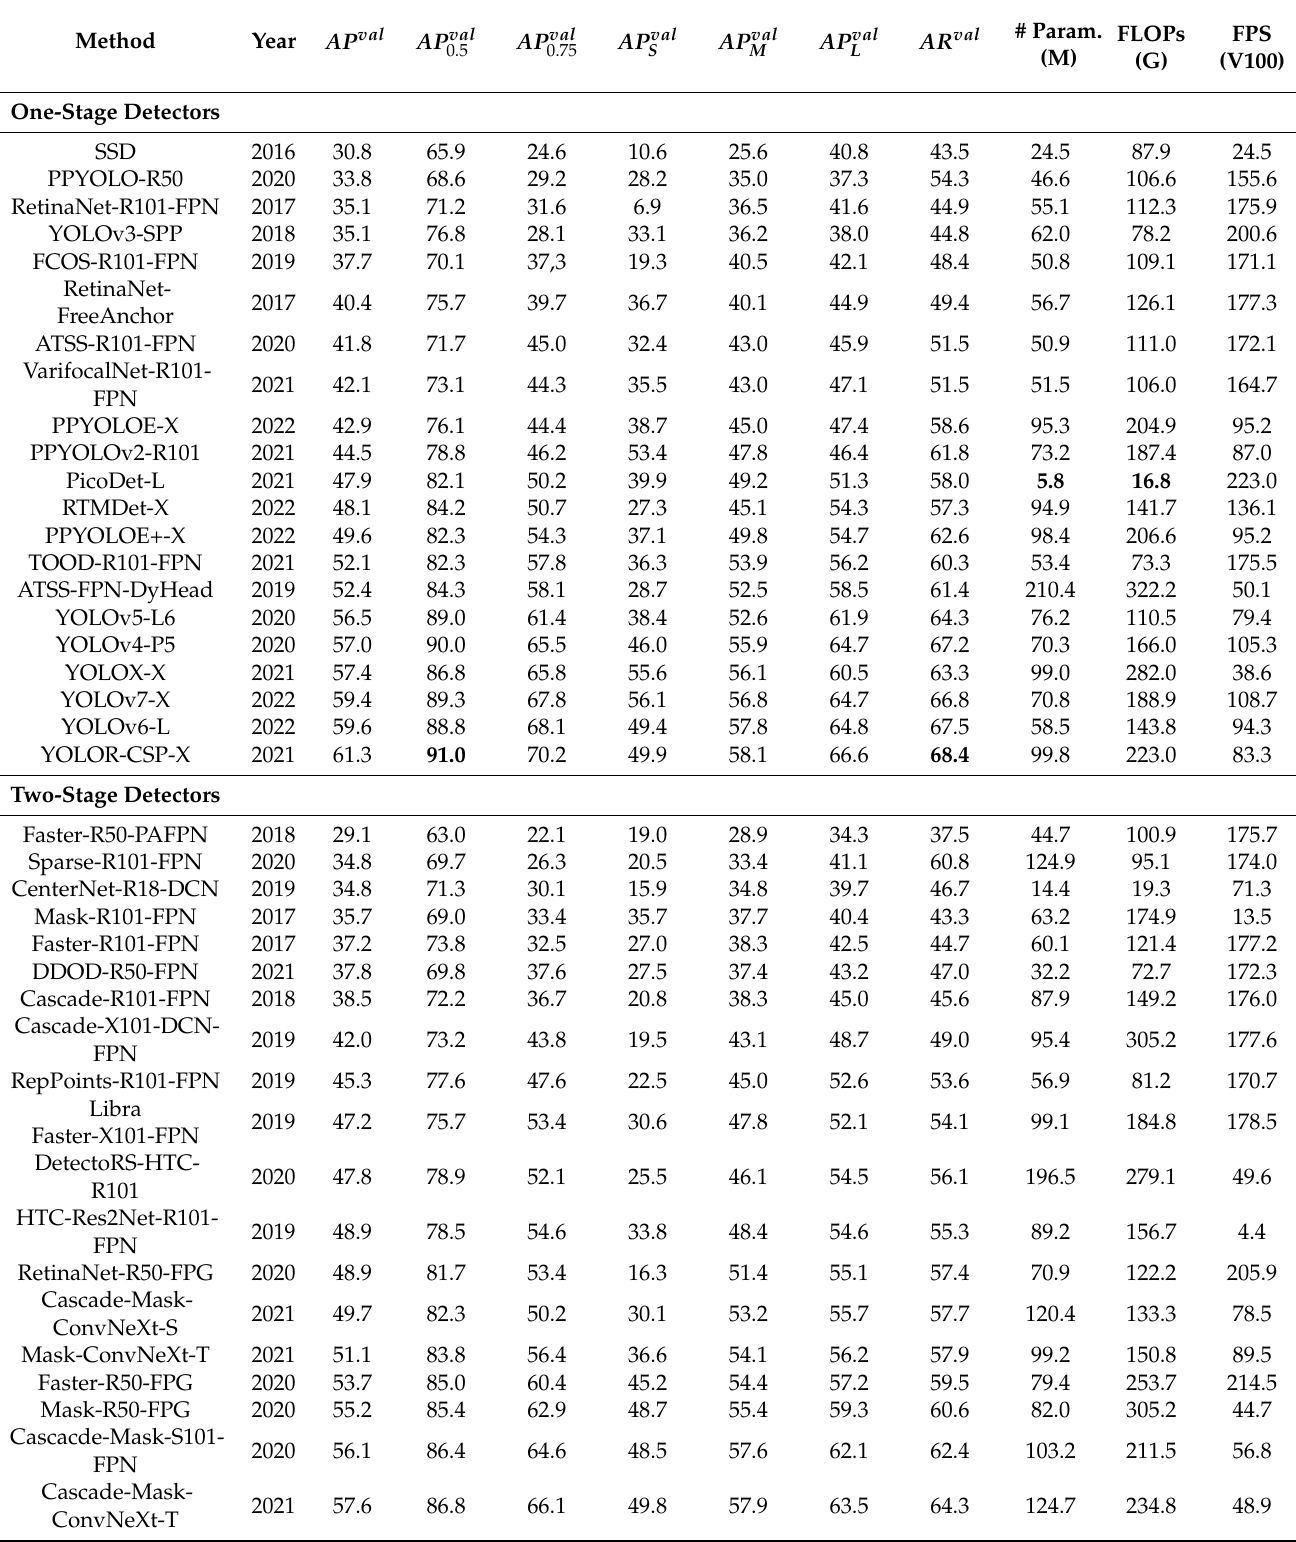
Table 2. Comparison results of our constructed model with standard one-stage object detection methods, two-stage object detection methods, and transformer-based object detection methods on the constructed